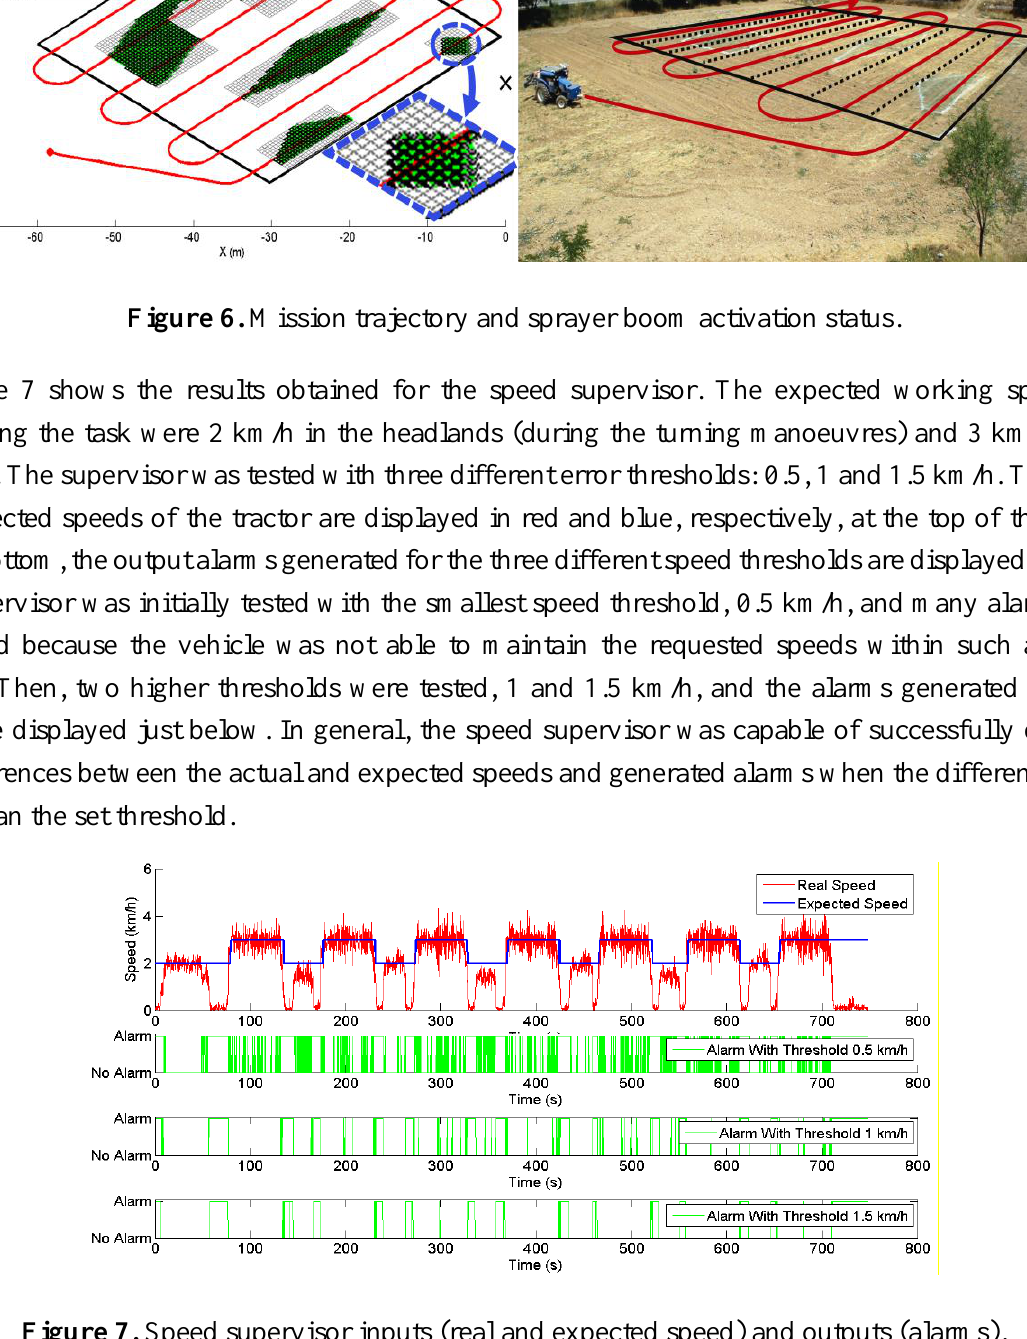
Figure 7. Speed supervisor inputs (real and expected speed) and outputs